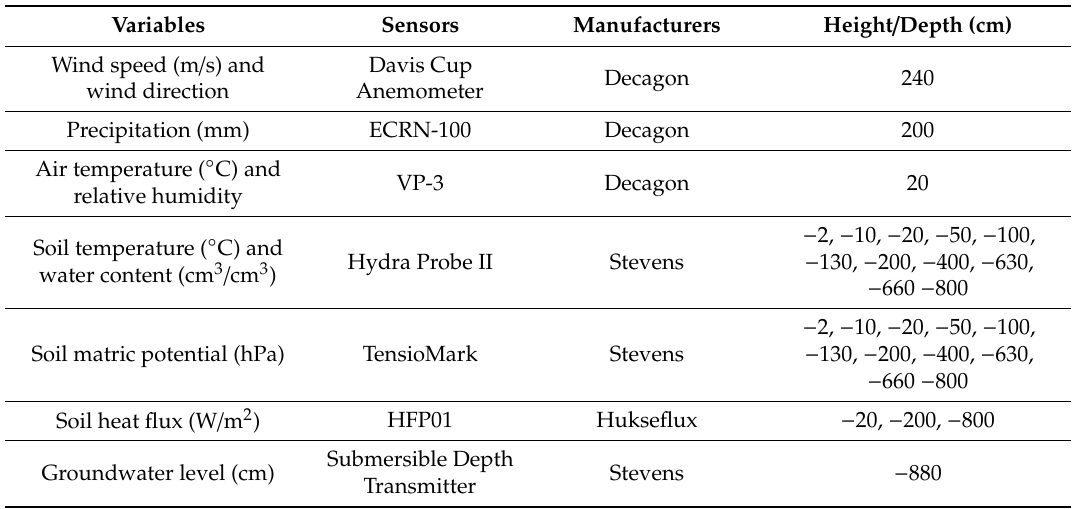
Table 2. Monitoring instruments at the study site. Positive heights mean that sensors were installed aboveground, while negative heights indicate that sensors were installed in the monitoring well below the surface. Soil temperatures and water contents measured at a depth of 2 cm were considered to represent the changes at the soil